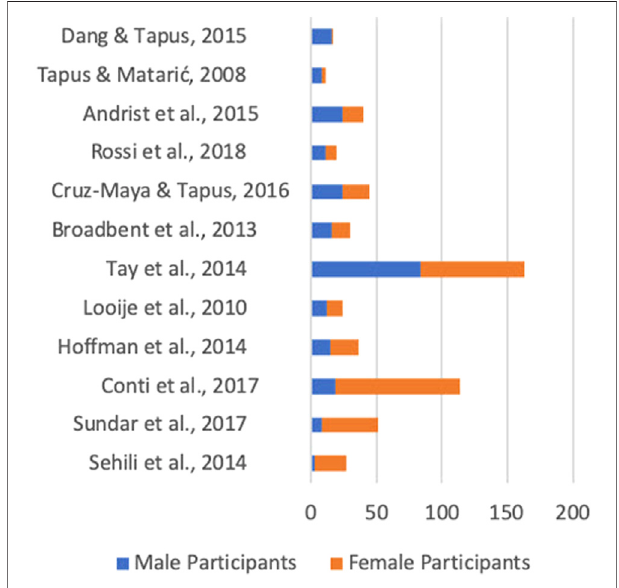
FIGURE 6 | Gender balance by